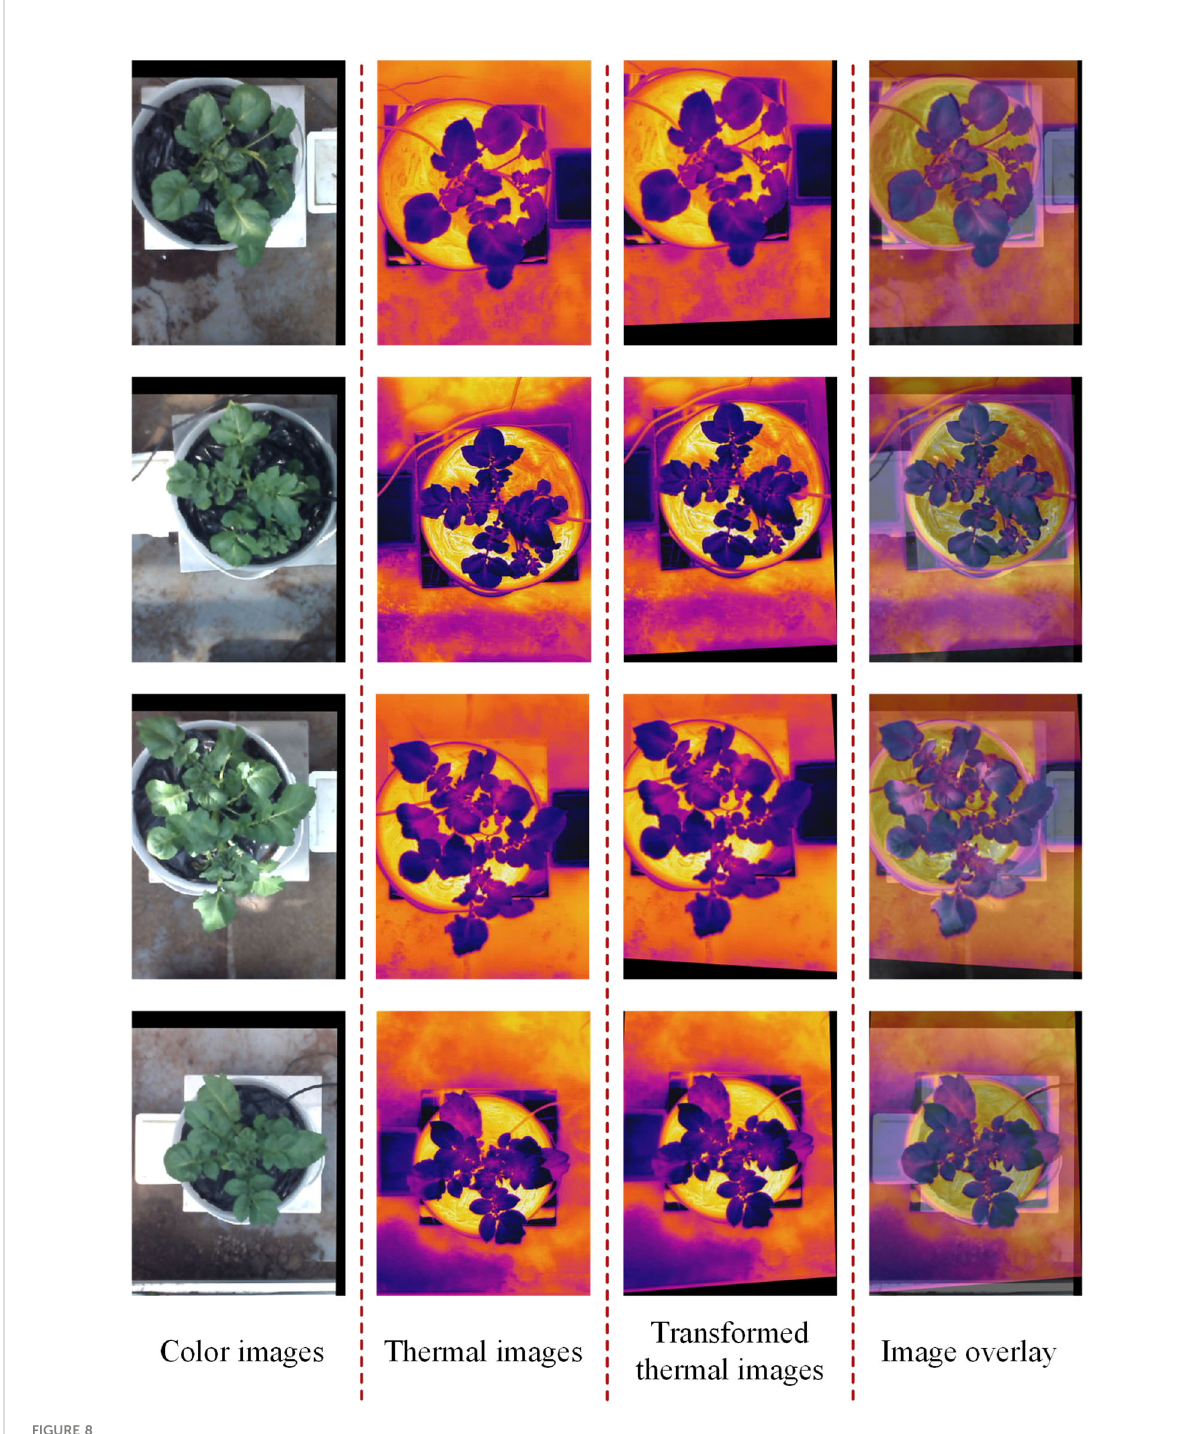
FIGURE 8 Registration results of the thermal and color images of potato